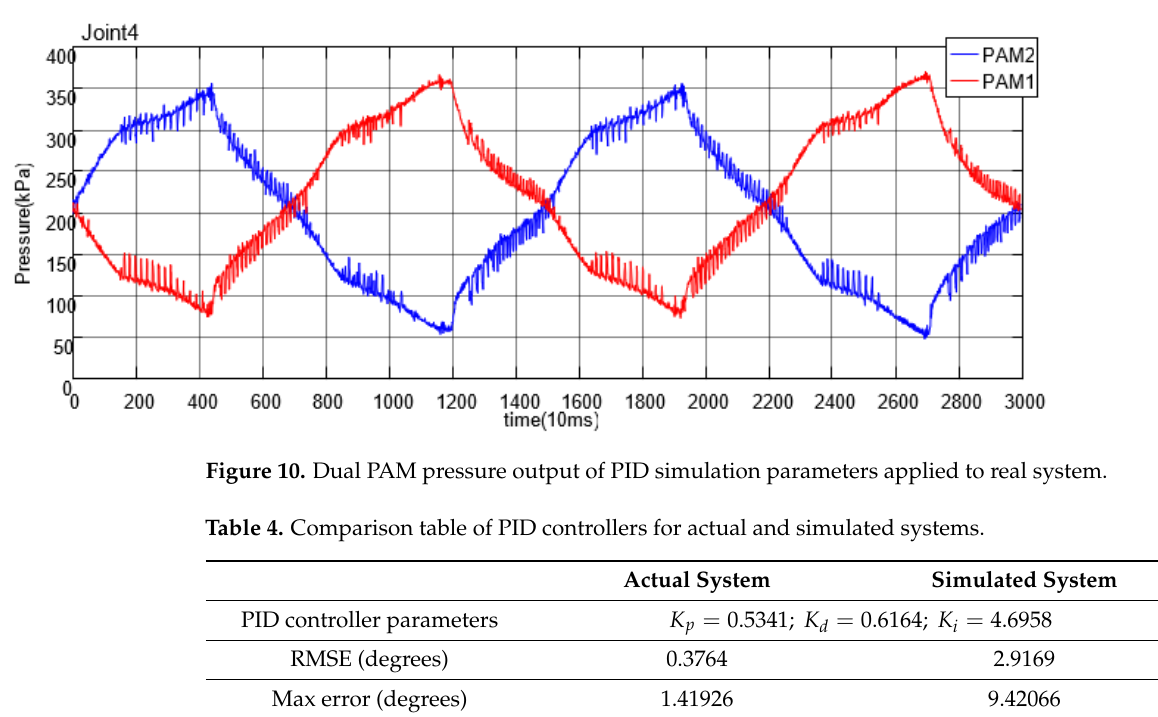
Figure 9. Tracking and error diagrams of PID simulation parameters applied to real system.